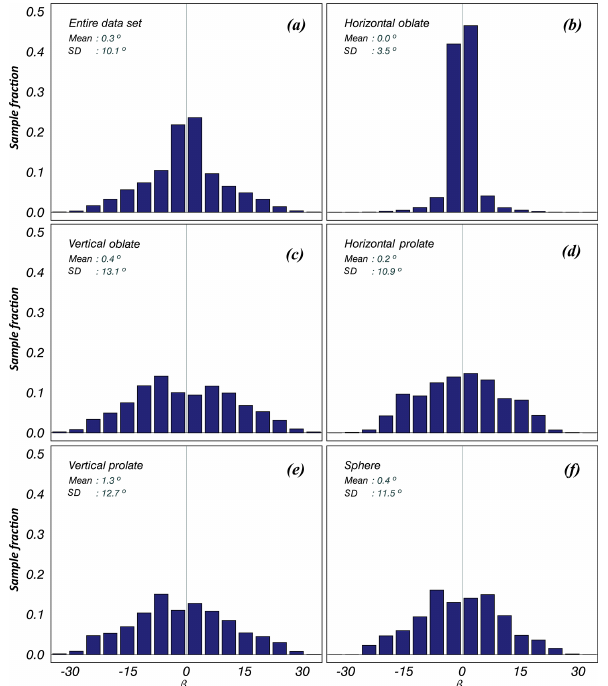
Figure 13. Histograms of representative canting angle ( β R ) for each particle shape type, including the data for all particles.